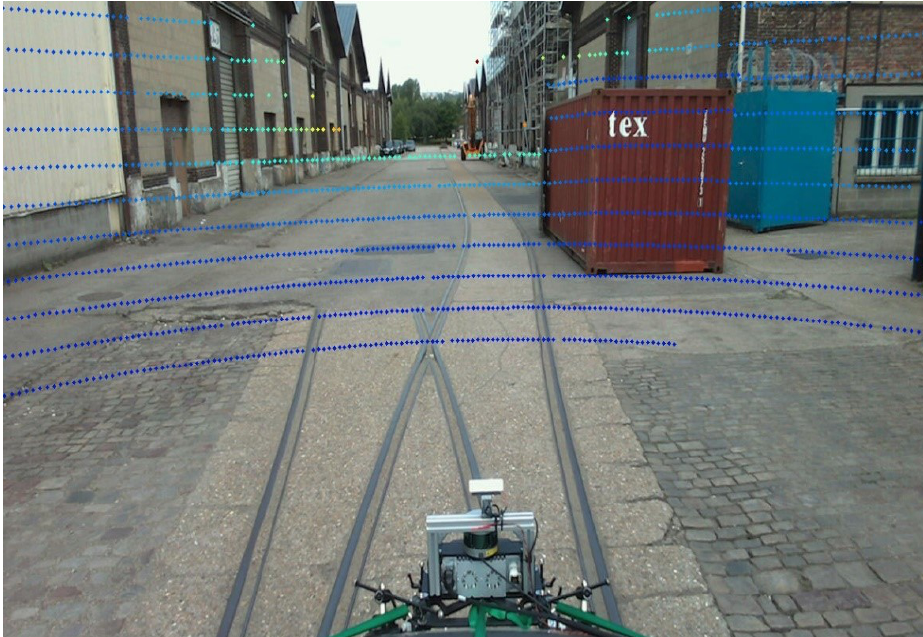
Figure 11. Overview of the result of the projection of the LiDAR points on an image of the railway dataset collected in Le Havre city (France). The coloring is related to the distance (depth) of the point from the